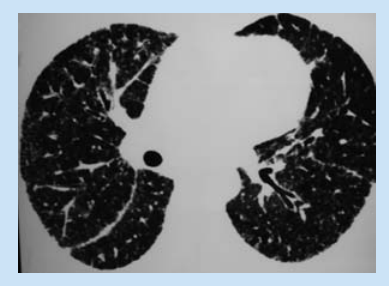
Fig. 23. Sarcoid with ‘beeding’.